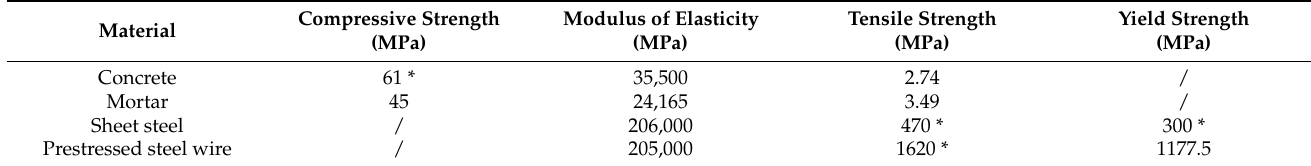
Table 2. Material properties of test PCCP.